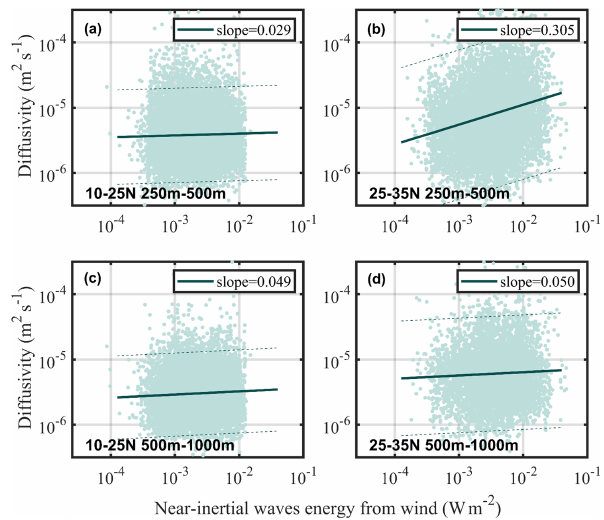
Figure 6. Scatterplot of log-scale K z versus log-scale, near-inertial energy flux from wind at 250–500m between (a) 10–25 ◦ N and (b) 25–35 ◦ N and in 500–1000m between (c) 10–25 ◦ N and (d) 25– 35 ◦ N. The best fit slopes are denoted by the solid line, and the 95% confidence interval is indicated by dashed